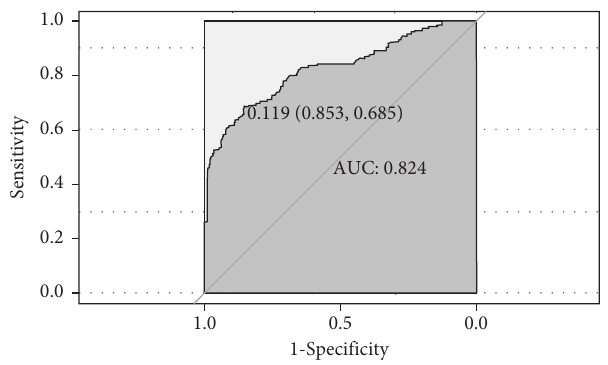
Figure 3: ROC curve for month two.